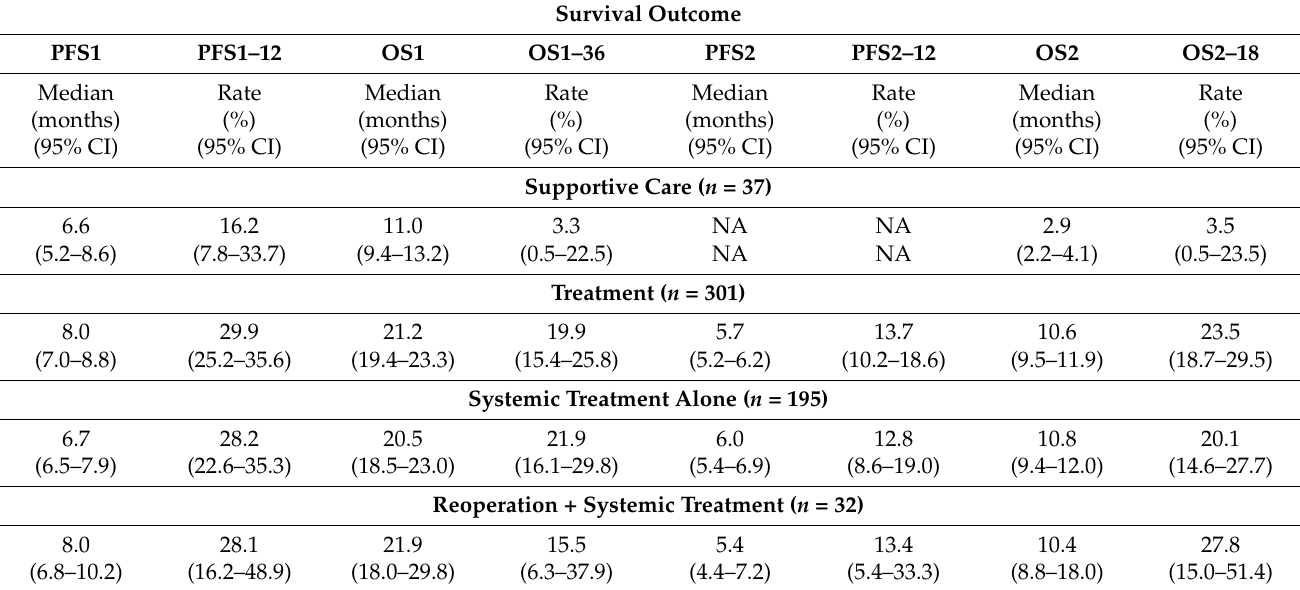
Table 3. Survival outcomes of IDH-wildtype GB patients as a function of second-line option. Survival